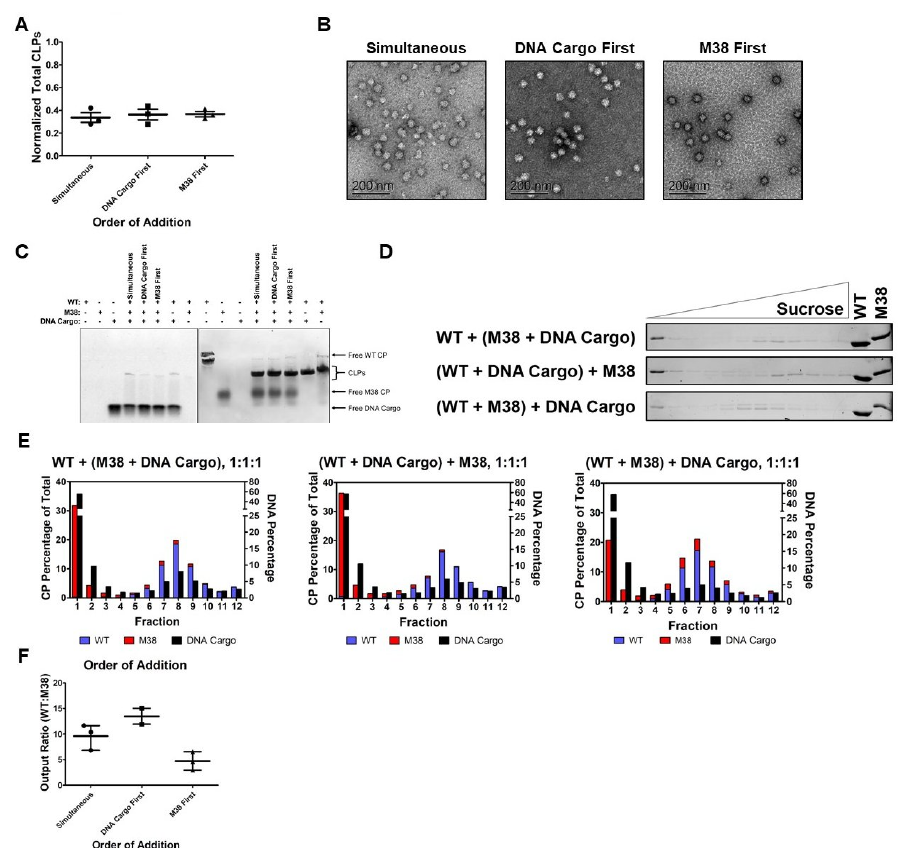
Figure 6. Order of addition a ff ects the composition of the WT + M38 + DNA cargo CLPs. ( A ) The amount of total CLPs formed (determined via DLS) did not change based on the order of addition of M38 CP and DNA cargo at the tested ratio. ( B ) Negative-stain TEM of the WT + M38 + DNA cargo CLPs showing that order of addition of M38 CP and DNA cargo did not alter the morphology of the CLPs. ( C ) Native gel-shift analysis of the unpurified CLP reactions. The WT + DNA cargo and WT + M38 reactions were assembled at a 1:1 molar ratio. The 1 WT + 1 M38 + 1 DNA cargo reactions were assembled in the order indicated above the gel. ( D ) Separation of WT + M38 + DNA cargo CLPs over a sucrose gradient by ultracentrifugation. The gels are representative of three biological replicates. The control lanes are 1.5 µ g concentrated protein. ( E ) Quantification of the protein and nucleic acid content in the fractions from the gels in ( D ). Protein content was quantified using densitometry, and nucleic acid content was quantified using fluorescence. Each data point was normalized so that the total protein signal in each graph would equal 100% and the total DNA signal would equal 100%. ( F ) Order of addition of M38 CP and DNA Cargo to WT CP changes the output ratio of WT:M38 CP, with the most M38 CP incorporated when M38 CP was added to WT CP prior to DNA cargo. Ratios are based on fraction 8 for DNA cargo first and simultaneous conditions, and fraction 7 for M38 first. Simultaneous = WT + (M38 + DNA cargo); DNA cargo first = (WT + DNA cargo) + M38; M38 first = (WT + M38) + DNA cargo.